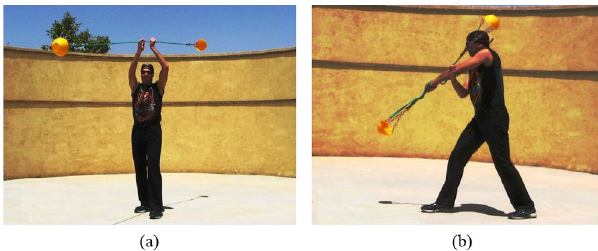
FIG. 2. (a) The artist spins two bowls filled with water in a horizontal plane. (b) The artist spins two bowls filled with water in a vertical